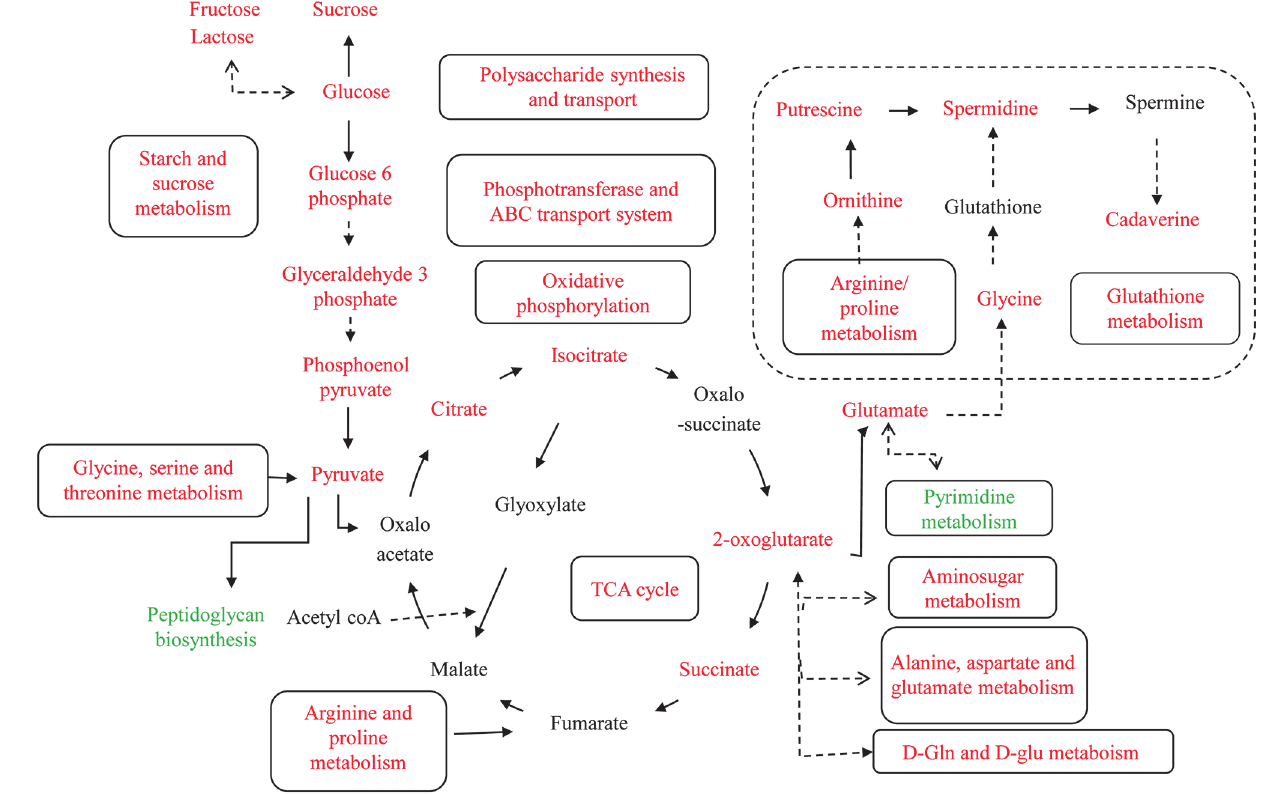
Fig 4. Metabolic pathways affected during adaptation to 2,4-D-induced stress. Metabolites and pathways colored in red and green are higher and lower, respectively in 2,4-D stressed Rlv compared with formula and sample controls. Metabolites colored in black were undetected. Enrichment analysis indicated that the majority of the metabolites identified were positively correlated with 2,4-D exposure, belonging to glycolysis, the TCA cycle, oxidative phosphorylation, ABC transport, the two component system and glutathione metabolism. Several pathways associated with pyrimidine and peptidoglycan metabolism were negatively correlated with 2,4-D